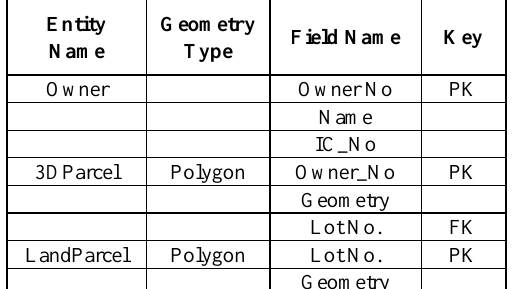
Table 1. Attribute for registered 3D cadastre object (Hassan, 2008) .